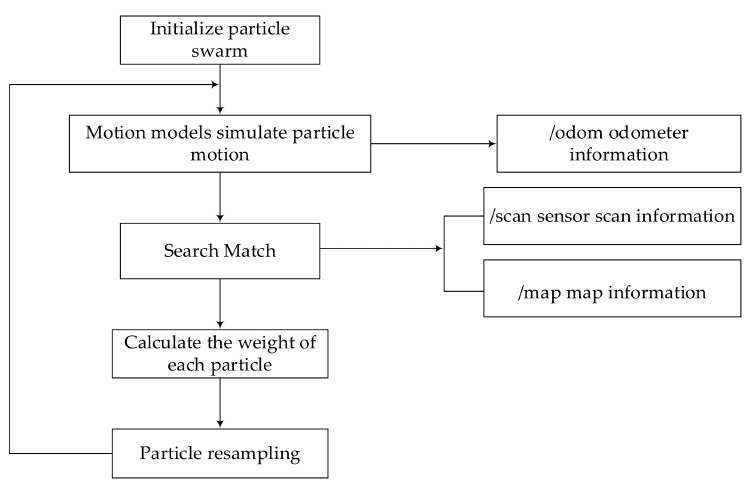
Figure 12. Block diagram of the AMCL